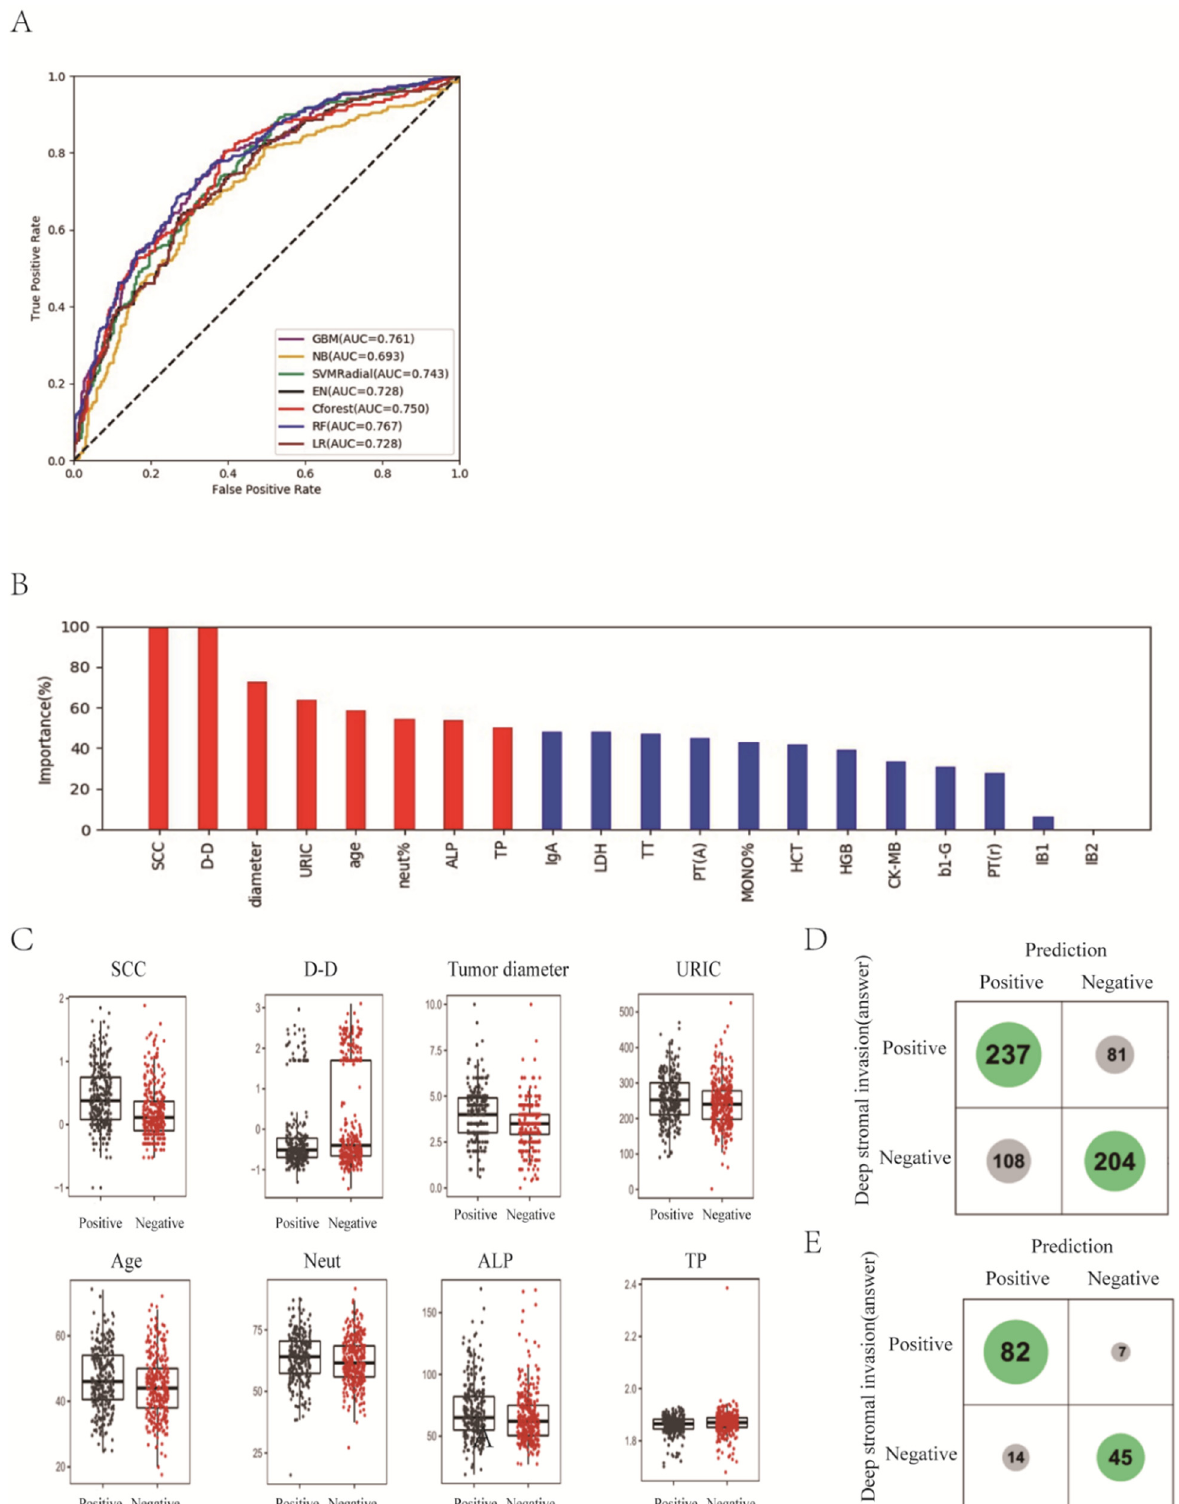
Figure 1. Prediction of deep stromal infiltration of cervical cancer based on multiple preoperative blood markers using machine learning methods. ( A ) ROC curves derived from logistic regression for predicting deep stromal infiltration of cervical cancer based on all 75 peripheral blood markers using machine learning methods compared with logistic regression. ( B ) Relative importance of variables for prediction of deep stromal infiltration calculated in the RF. Variable importance is represented